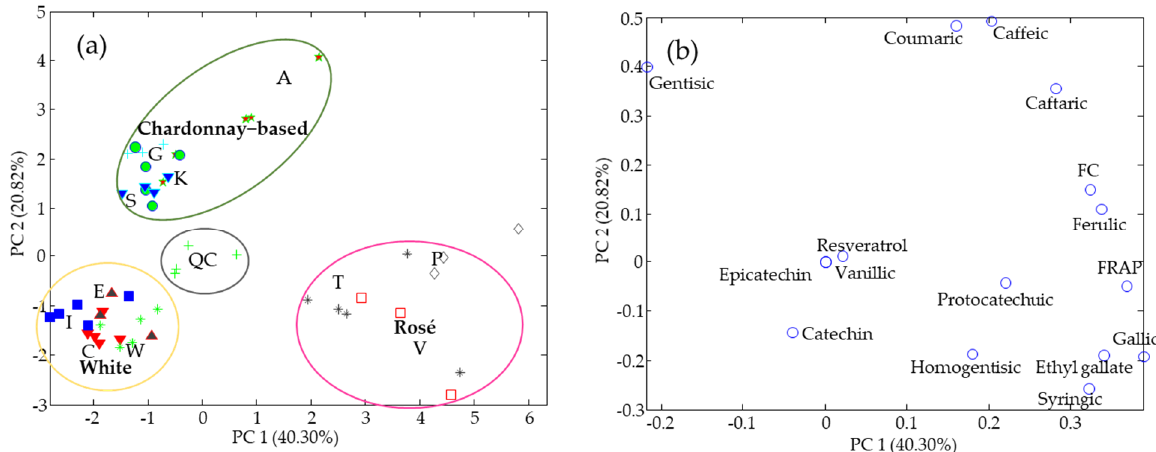
Figure 1. PCA results from the study of polyphenol concentrations and indexes for the total antioxidant capacity. Plot of scores ( a ) and plot of loadings ( b ). Cava class assignation: see Table 2.